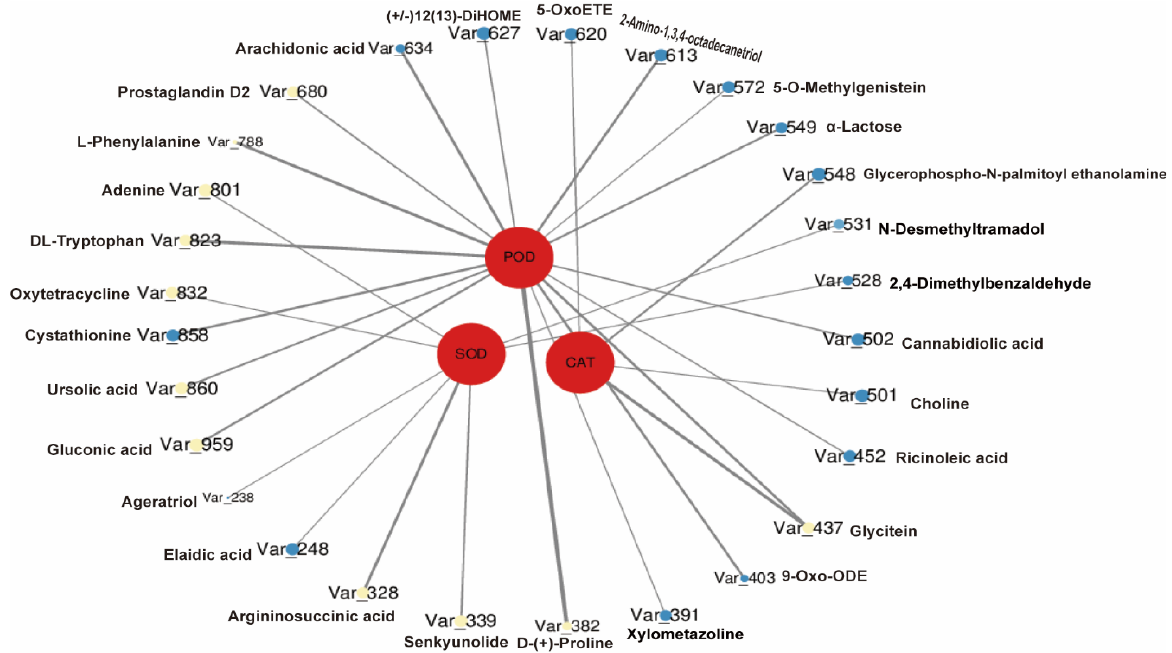
Figure 9. Network diagram between antioxidant capacity and metabolites. Red circles indicate different antioxidant enzymatic activities of guaiacol peroxidase (POD), superoxide dismutase (SOD), and catalase (CAT). Yellow represents a positive correlation between metabolites and antioxidant enzymes, and blue is a negative correlation; the size represents the p -value (the smaller the p -value, the larger the size), and the line connecting shows the circle denoting the correlation, with the thicker the line, the greater the correlation coefficient (| r | ≥ 0.9 and p < 0.05).